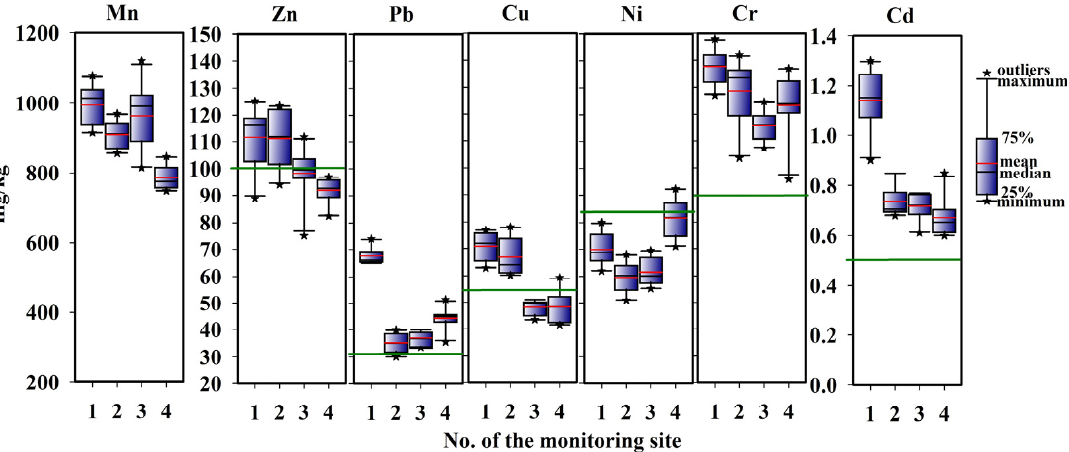
Figure 2. The total concentration of HMs in agricultural fields soil located near the power station over a 10-year monitoring period. Green line is the maximum permissible concentrations (MPC). *—outlier.